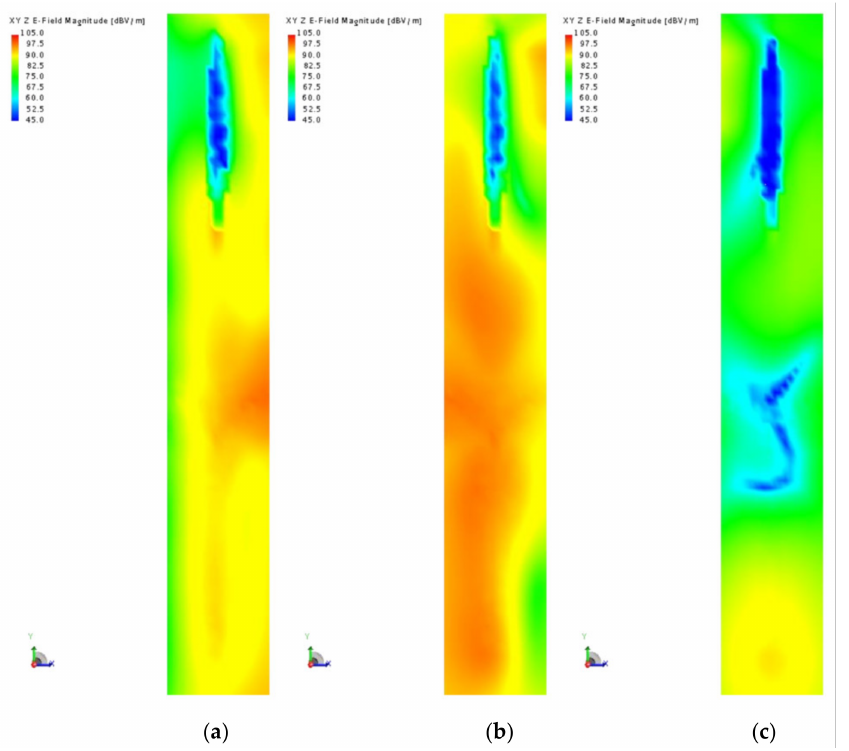
Figure 8. Electric field strength distribution E ( t ) of top layer on the aircraft with different time t .